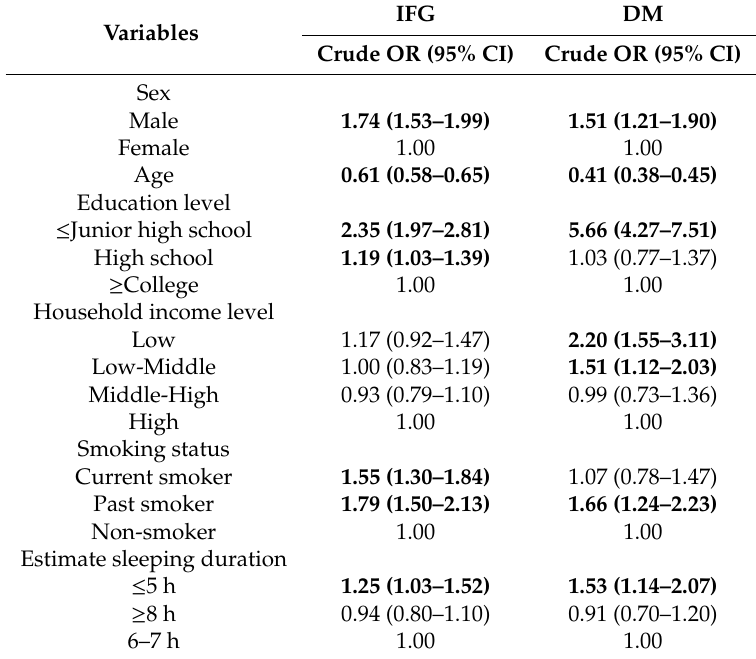
Table 2. The prevalence of fasting serum glucose disorder and diabetes without periodontitis.